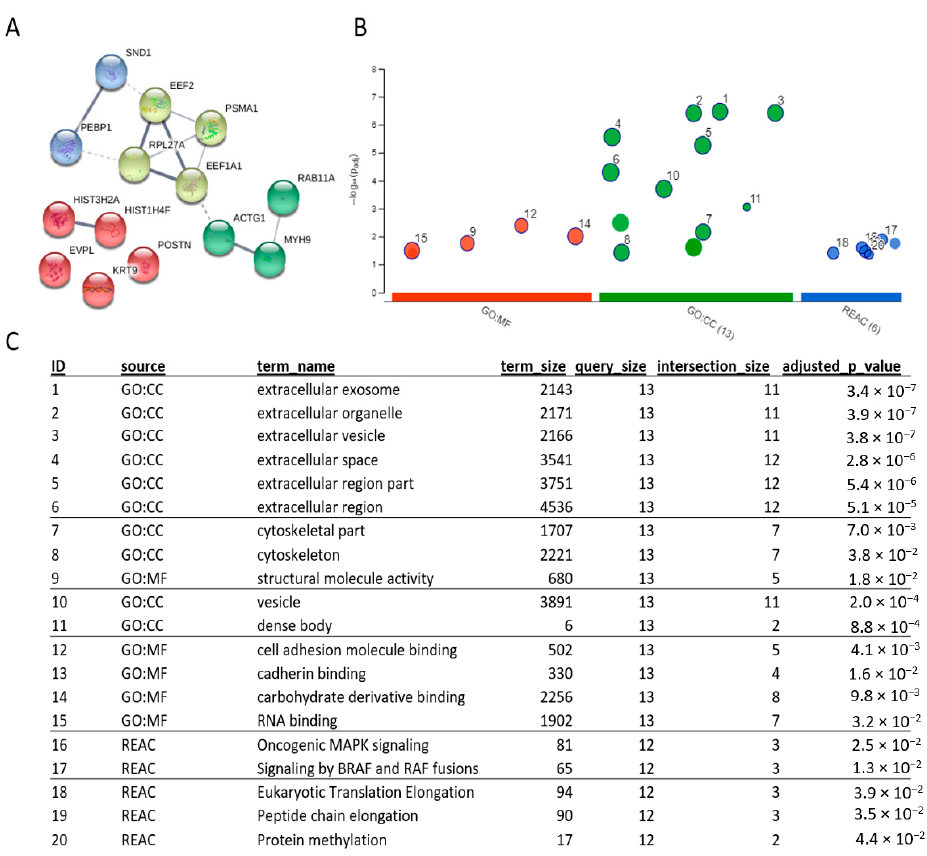
Figure 4 Figure 4. Analysis of significantly di ff erentially expressed proteins highlighted processes involved in metastasis. ( A ) String analysis of significantly di ff erentially expressed proteins. Cluster analysis based on protein-protein interactions revealed 4 clusters. ( B , C ) Gene ontology enrichment analysis of significantly di ff erentially expressed proteins highlighted several areas of ontology including extracellular space, cytoskeletal, vesicles and binding. GO; Gene ontology. CC; cell compartment. MF;